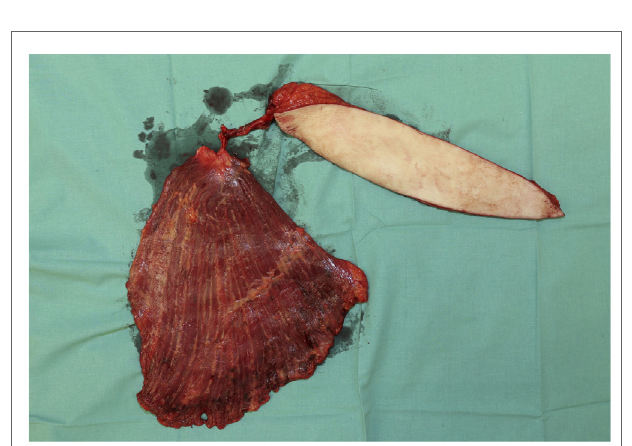
FiGURe 7 | The combined latissimus/parascapular flap after its elevation on the common vascular pedicle